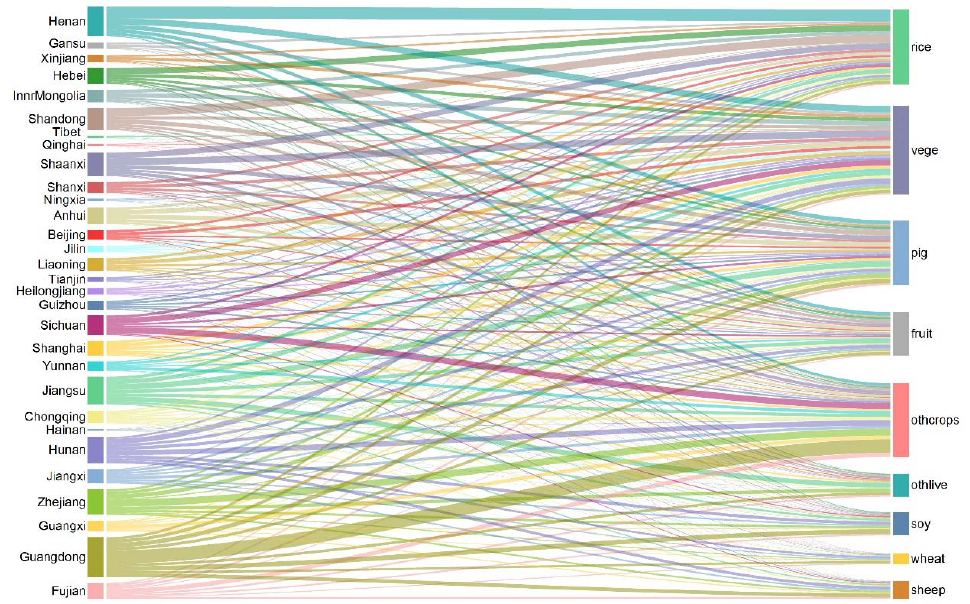
Figure 5. Changes in the amount of agriculture production exported from other provinces to Hubei provinces under SIS